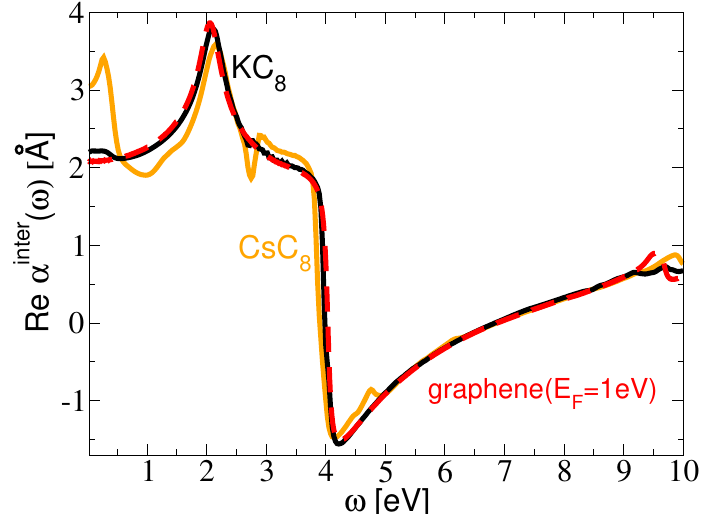
Figure 2. The interband contribution to the dynamical polarizability α inter ( ω ) for the KC 8 (black), CsC 8 (orange) and doped graphene (red dashed). The graphene is doped so that the Fermi energy is 1eV above Dirac point, which corresponds to the doping of the π bands in the KC 8 and CsC 8